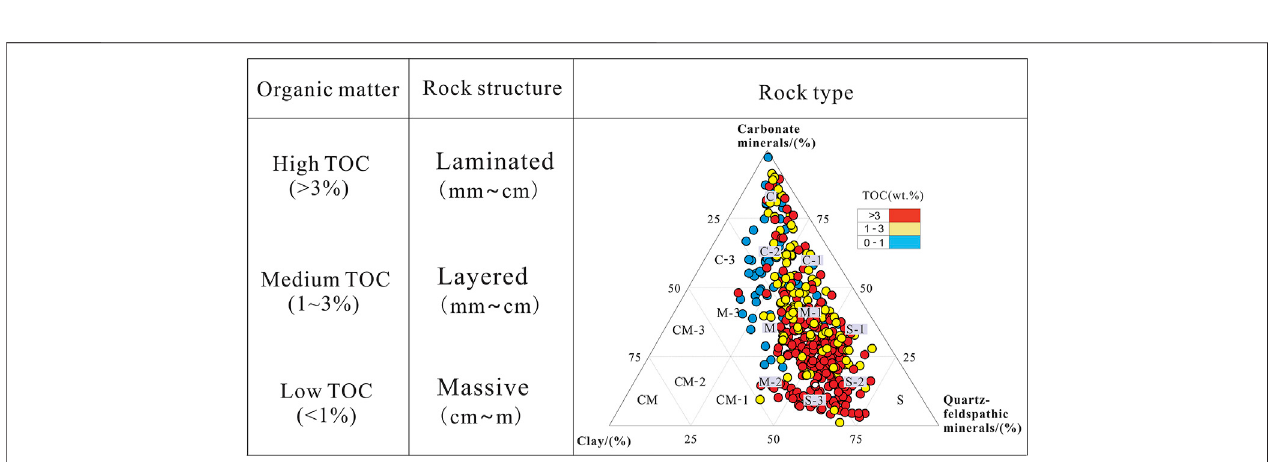
FIGURE 4 | Lithofacies classi fi cation standard of the lacustrine shale system in the study area. C: Low organic matter (OM) — massive — carbonate shales. C1: Medium to high OM — laminated — siliceous carbonate shales. C2: Low to medium OM — layered — mixed carbonate shales. S1: Medium to high OM — laminated — carbonate siliceous shales. S2: Medium to high OM — massive — mixed siliceous shales. S3: Medium to high OM — laminated — argillaceous siliceous shale. M: Low to medium OM — massive -mixed shale. M1: Medium to high OM — laminated — mixed shale.